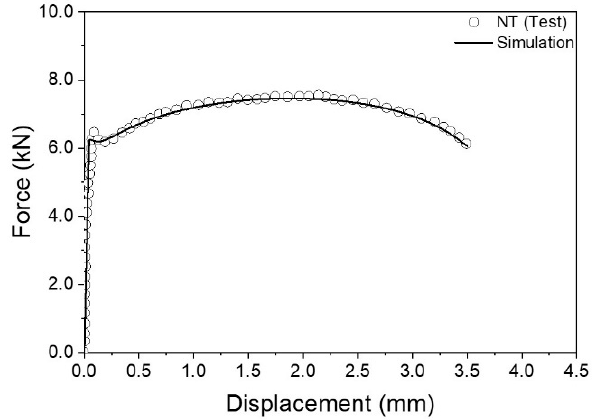
Figure 6. Comparison of experimental and simulated force-displacement curves for NT. Table 2. Swift hardening law parameters of JIS G3131 SPHC.